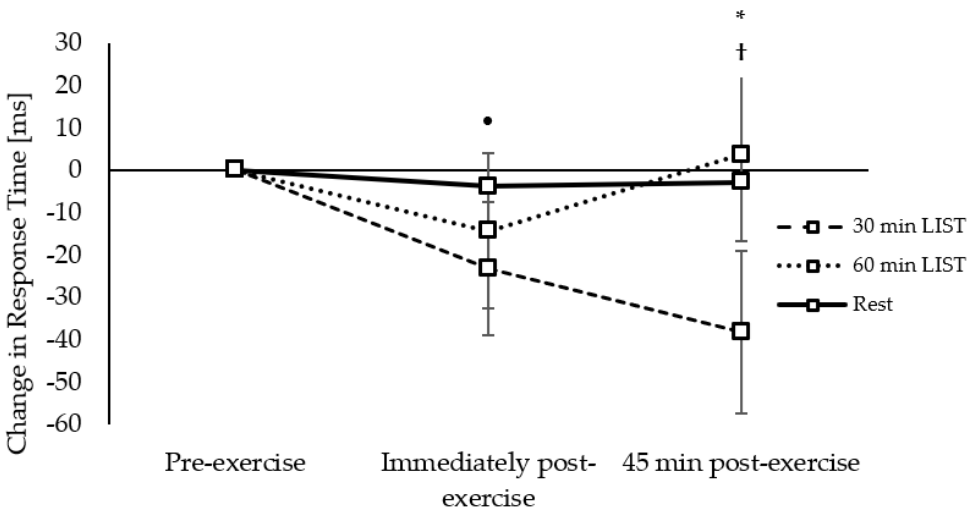
Figure 3. Change in response times across the morning on the 30 min LIST, 60 min LIST, and resting control trials on the simple level of the Stroop test. Faster response times following 30 min LIST vs. 60 min LIST * and rest †; both p < 0.05. Tendency for faster response times following 30 min LIST vs. rest; p = 0.058 •.